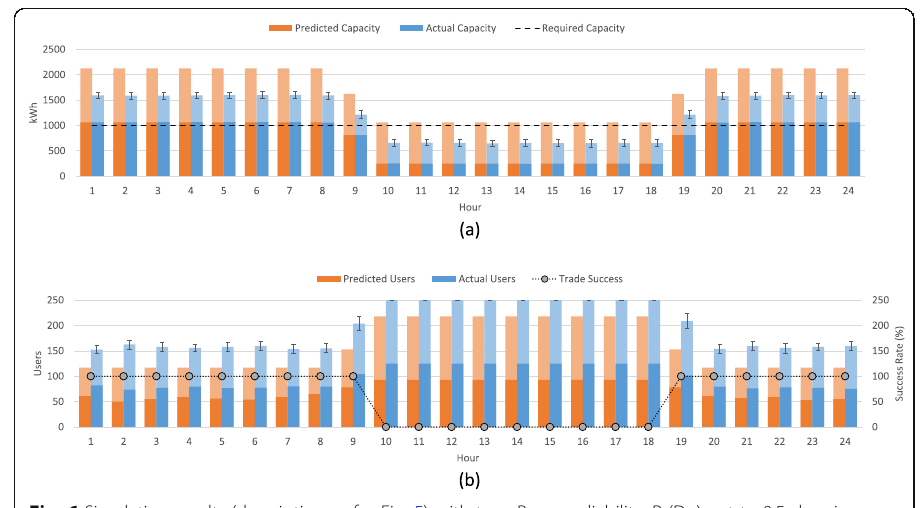
Fig. 6 Simulation results (description as for Fig. 5) with type B user reliability, P (Dn), set to 0.5 showing prediction errors for type B (light column